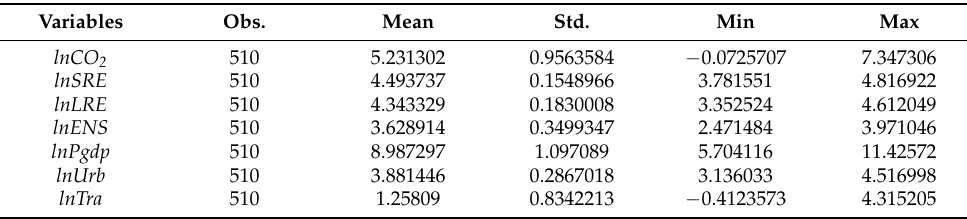
Table 1. Descriptive statistics of each variable.